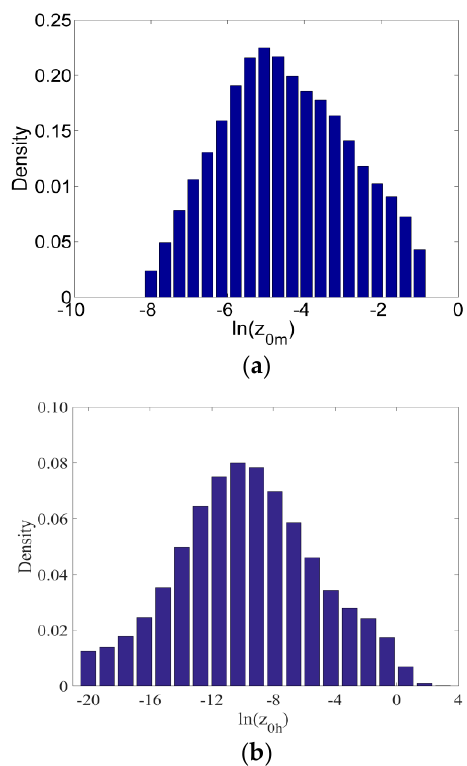
Figure 6. ( a ) Frequency distribution of the estimated ln( z 0 m ) parametric density at Xiaotang station from 5 January to 31 December 2010. The optimal value of ln( z 0 m ) was − 5.14, which has the highest frequency in the curve. ( b ) Same as ( a ) but for ln( z 0 h ) where ln( z 0 h ) was − 8.54.